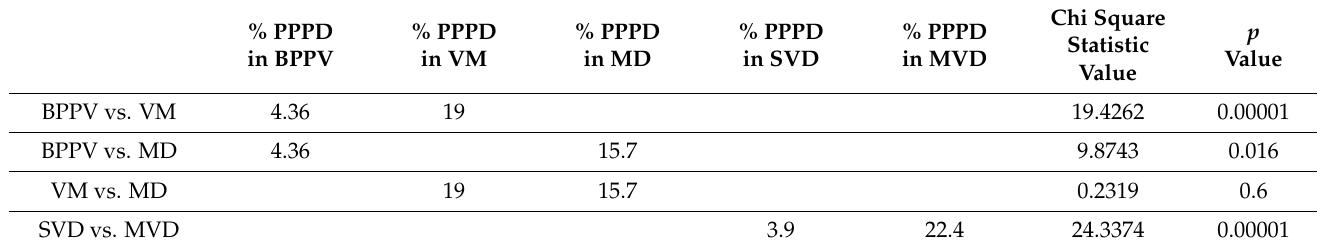
Table 2. Incidence (%) of the Persistent Postural Perceptual Dizziness in the episodic vestibular disorders considered as comorbidities. Statistical evaluation and comparison between the groups.